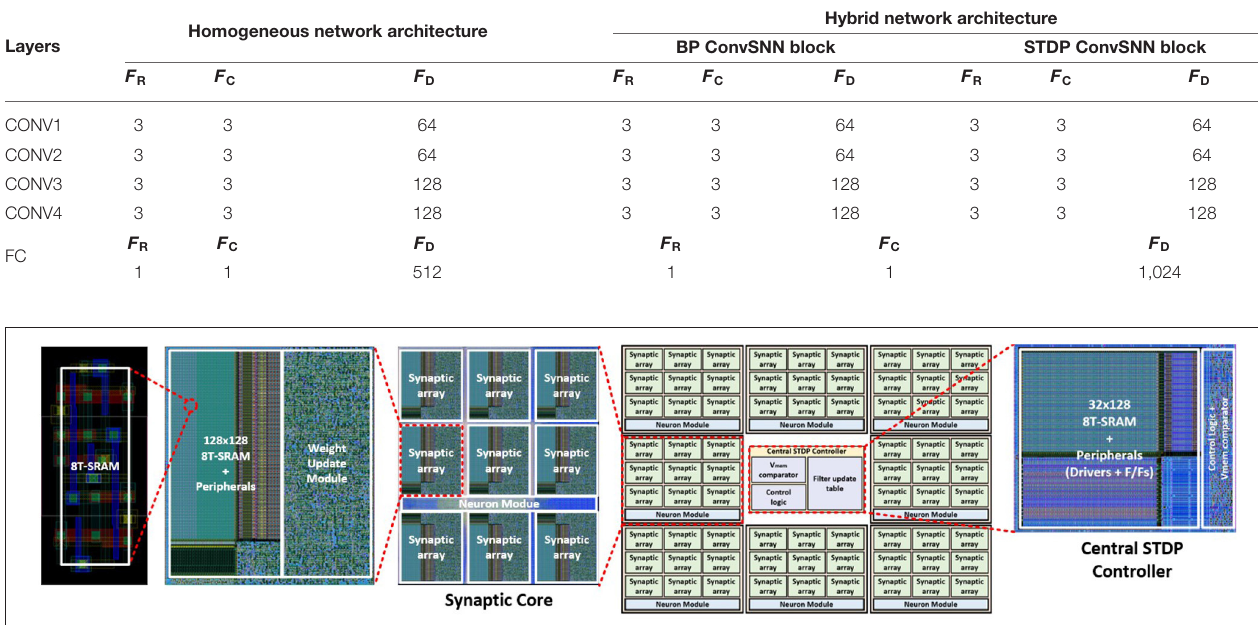
FIGURE 15 | The overview of the physical design of MONETA.